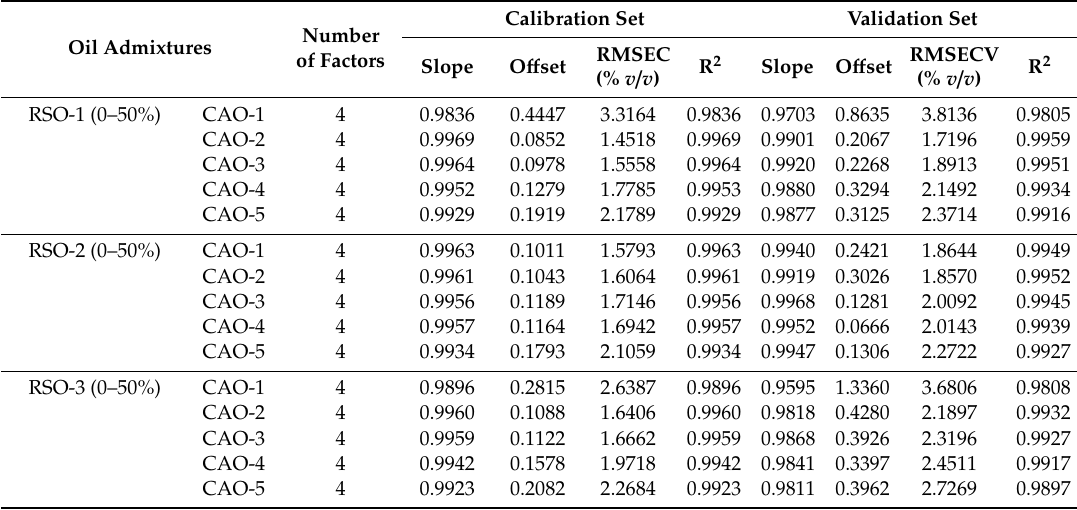
Table 4. Calibration and validation results of the partial least squares regression (PLSR) models for the mixtures of RSOs in CAOs from 1800–650 cm − 1